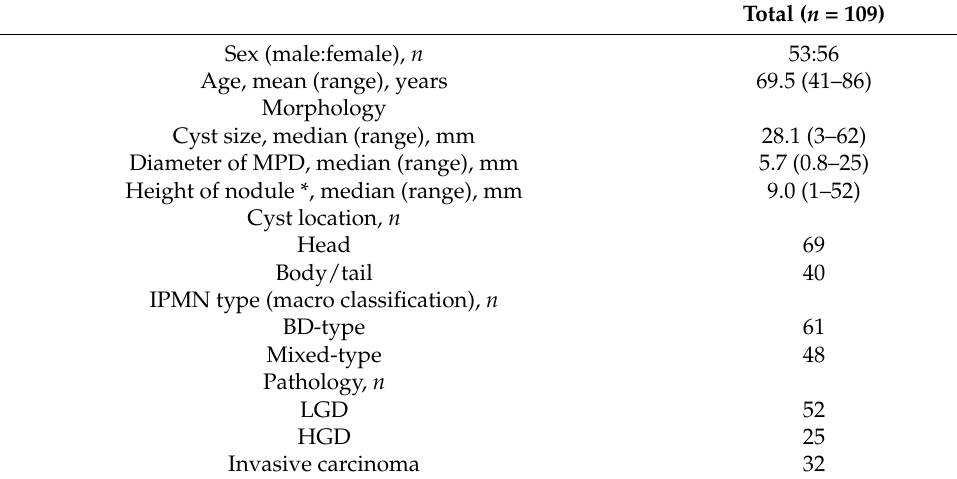
Table 1. Baseline characteristics of the